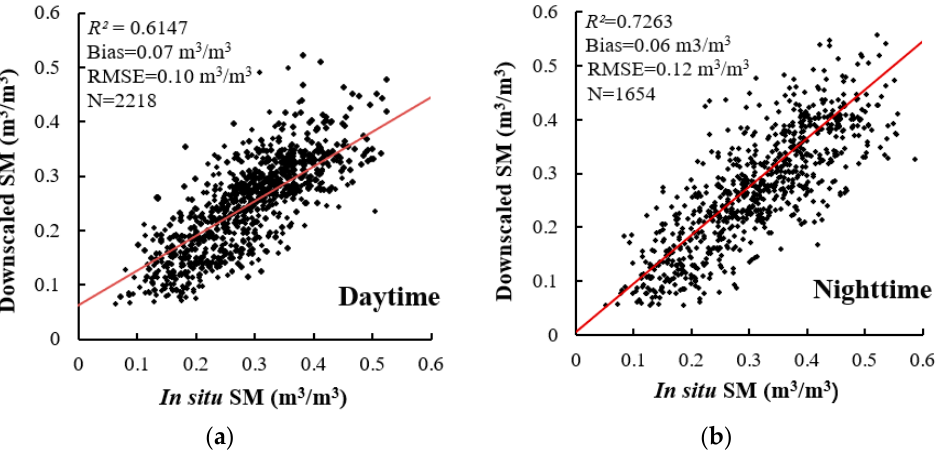
Figure 3. Downscaled soil moisture (SM) (1-km scale) based on the spatial fusion downscaling model (SFDM) versus the in situ SM: ( a ) daytime; ( b ) nighttime. The solid line is the trend line.